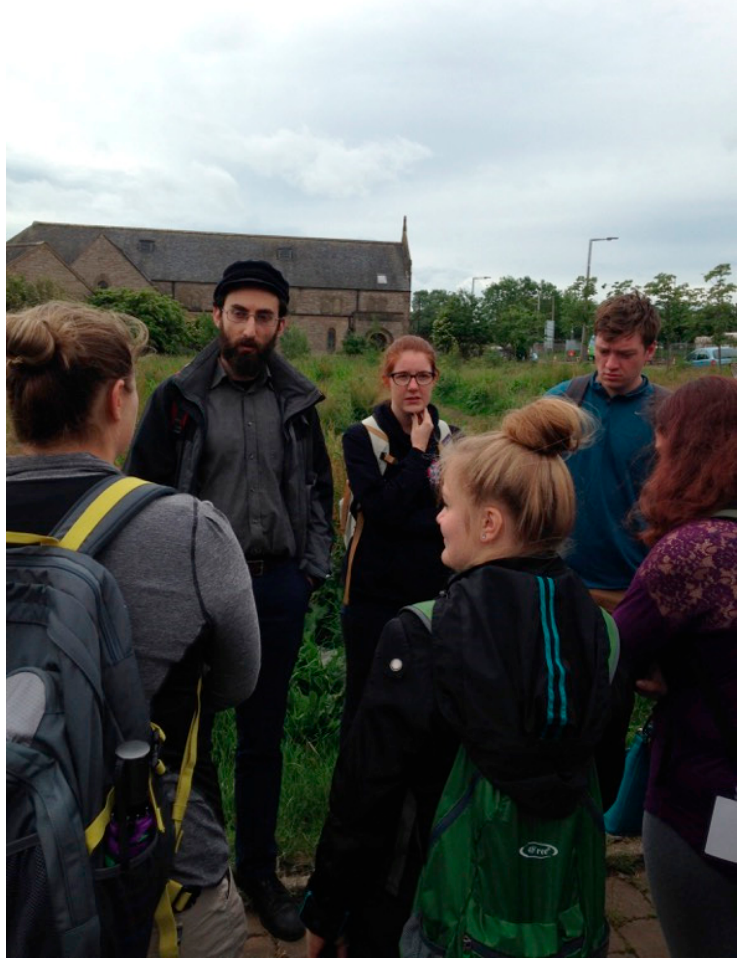
Figure 4. Dr. Hamish Kallin, University of Edinburgh, discussing the history of Craigmillar with students enrolled in the Edinburgh: City and Environment program (Photo by G.L. Buckley, June 2017).